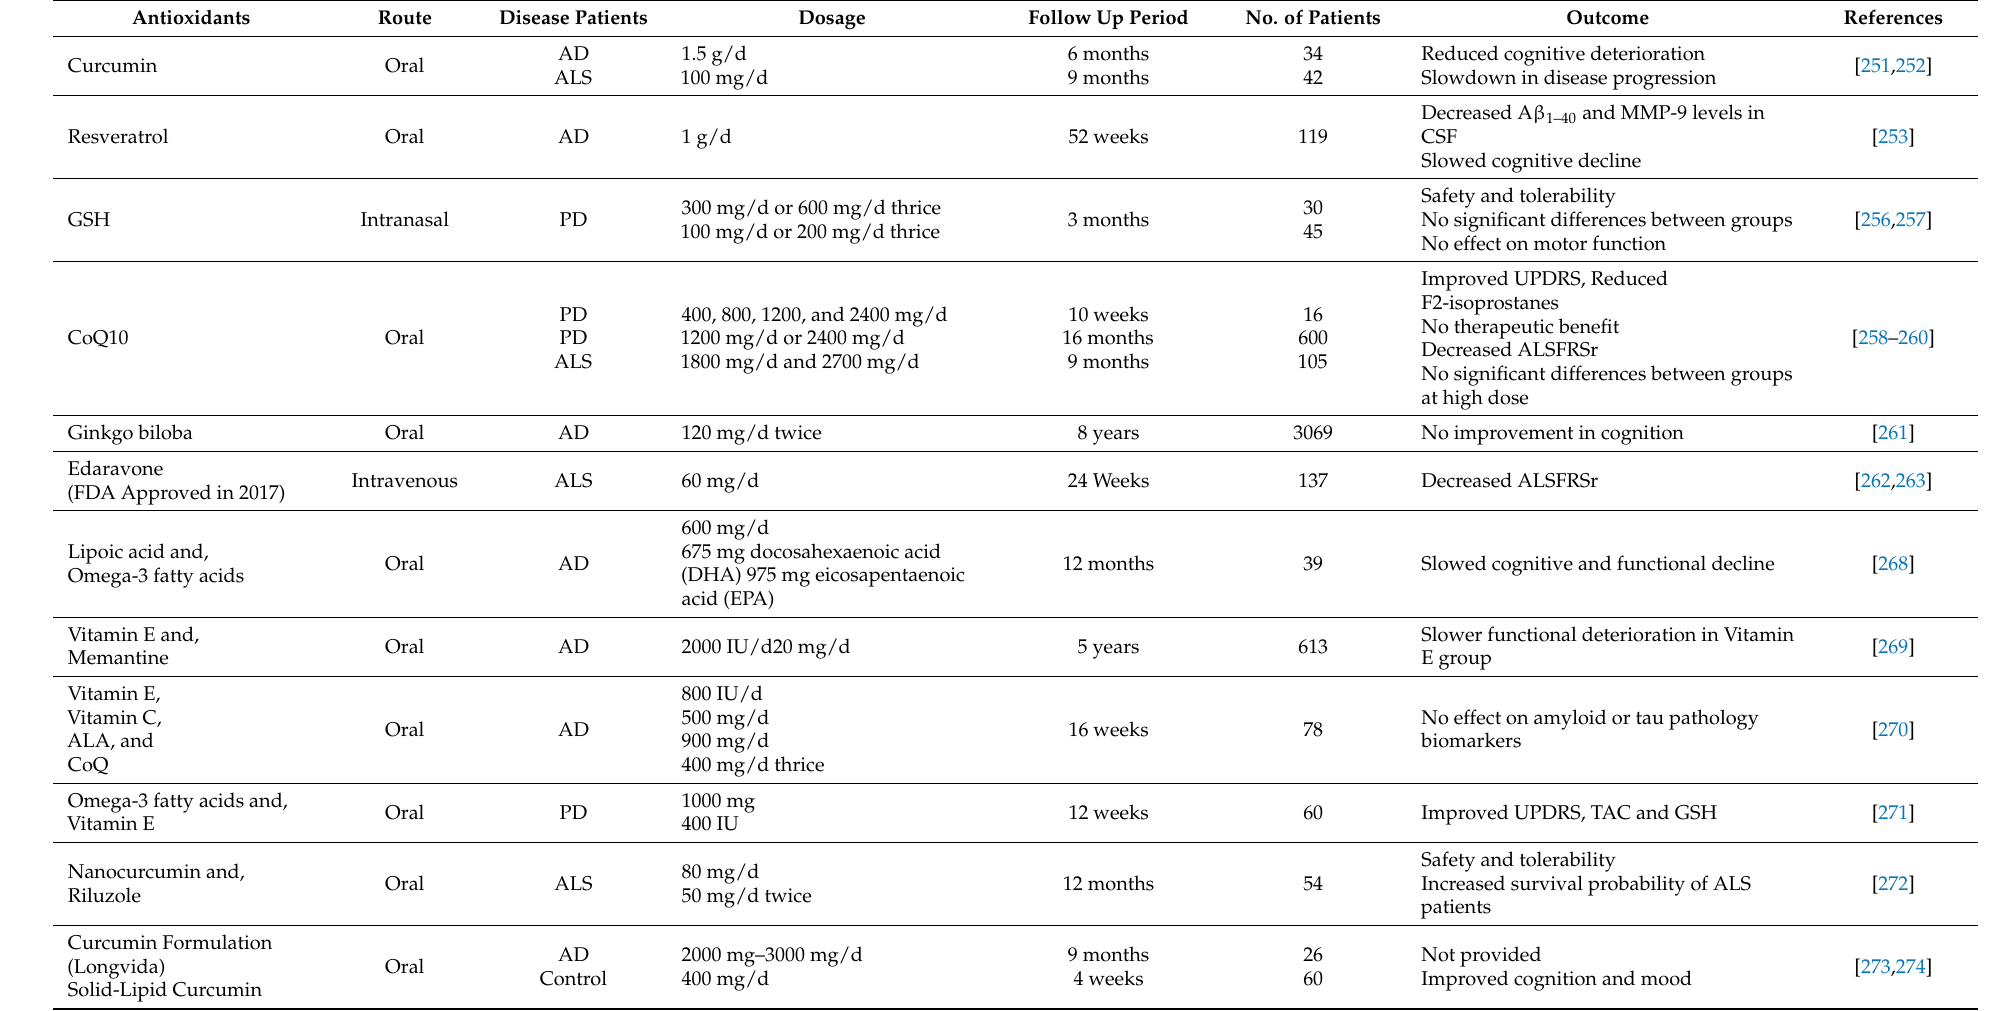
Table 1. Clinical trials of antioxidants in neurodegenerative